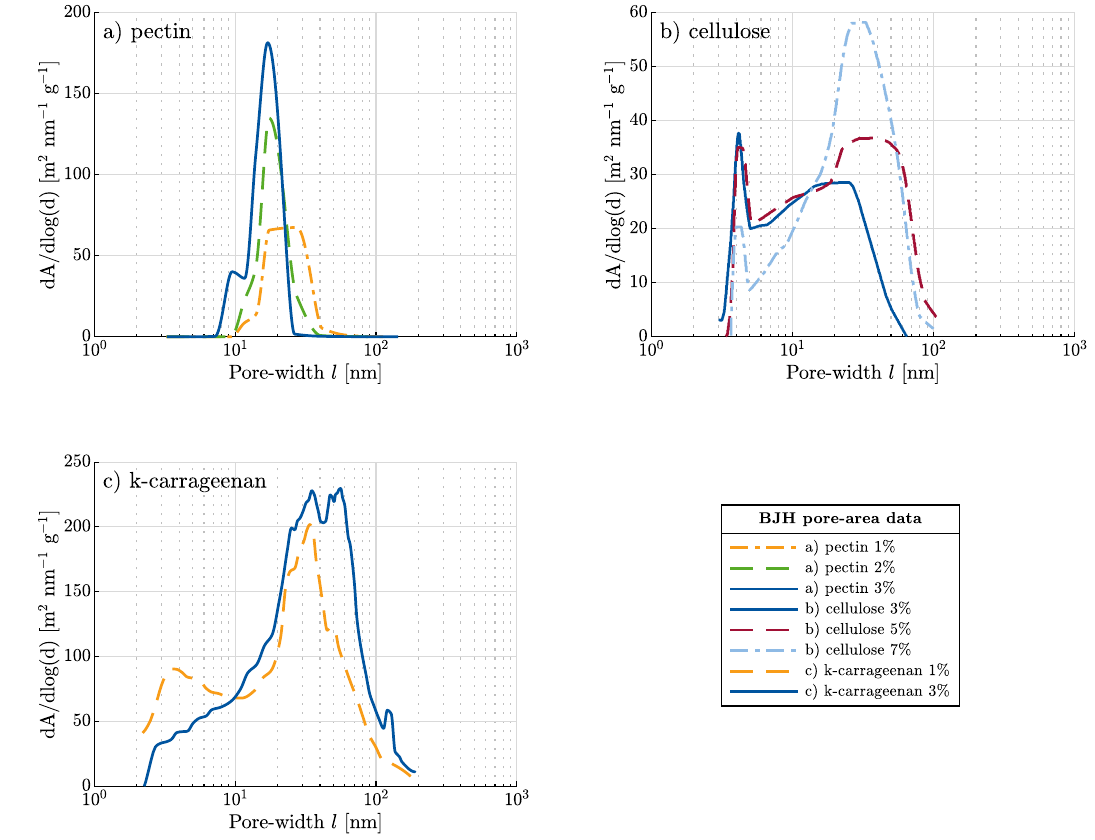
Figure 1. Pore size area distributions with varying biopolymer concentrations for polysaccharide-based aerogels: ( a ) pectin, ( b ) cellulose and ( c ) k-carrageenan. Table 1. Textural properties of polysaccharide-based